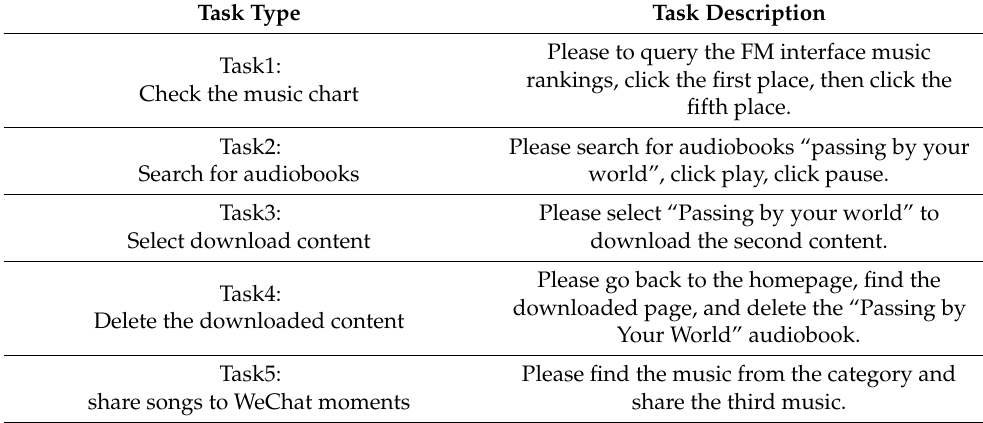
Table 1. The experimental tasks of FM new media